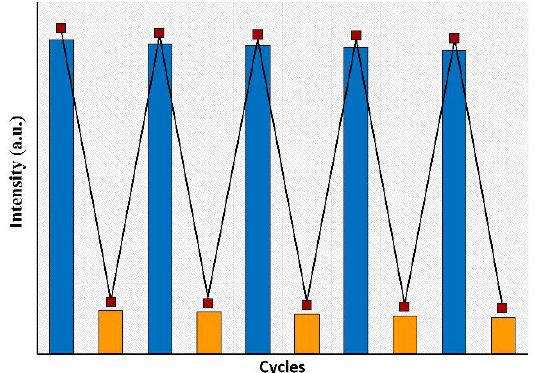
Figure 5. The quenching cycle test of 1 after adding 50 µ M TNP in water.